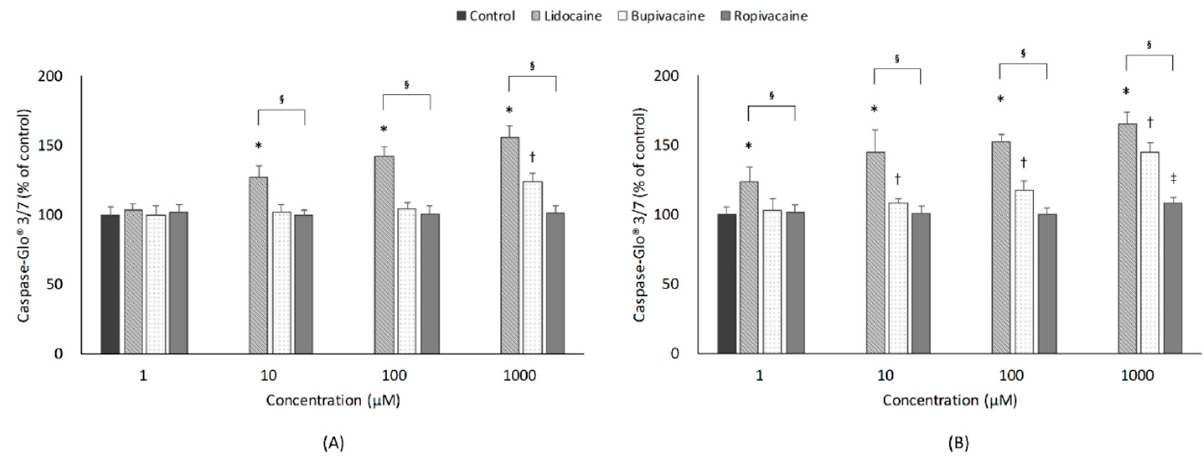
Figure 4. Effects of local anesthetics on cellular apoptosis, which was assessed by Caspase-Glo 3/7 assay. Developing motor neurons were exposed to the indicated concentrations (1, 10, 100, or 1000 µM) of local anesthetics for ( A ) 1 h or ( B ) 24 h. All data are expressed as means ± standard deviations. Differences between the results were evaluated by two-way ANOVA, followed by Dunnett’s test for multiple comparisons. * p < 0.05, lidocaine vs. control group. † p < 0.05, bupivacaine vs. control group. ‡ p < 0.05, ropivacaine vs. control group. § p < 0.05, differences among the 3 groups by ANOVA.